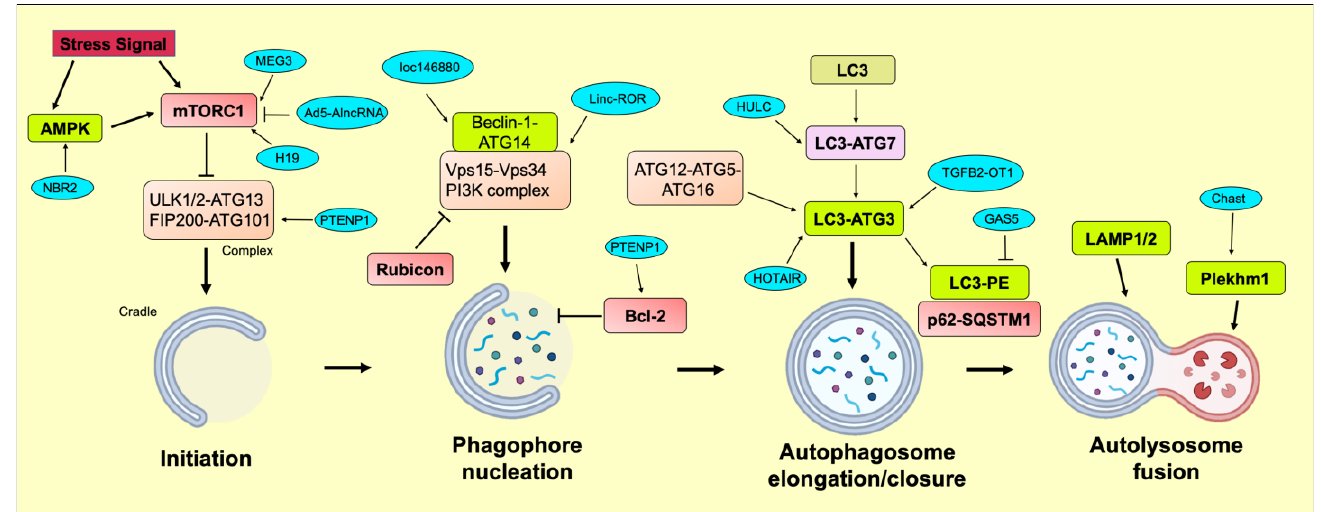
Figure 1. Mechanistic action of different lncRNAs in regulating the autophagic process of initiation, phagophore formation, autophagosome elongation/closure, and autolysosome fusion.